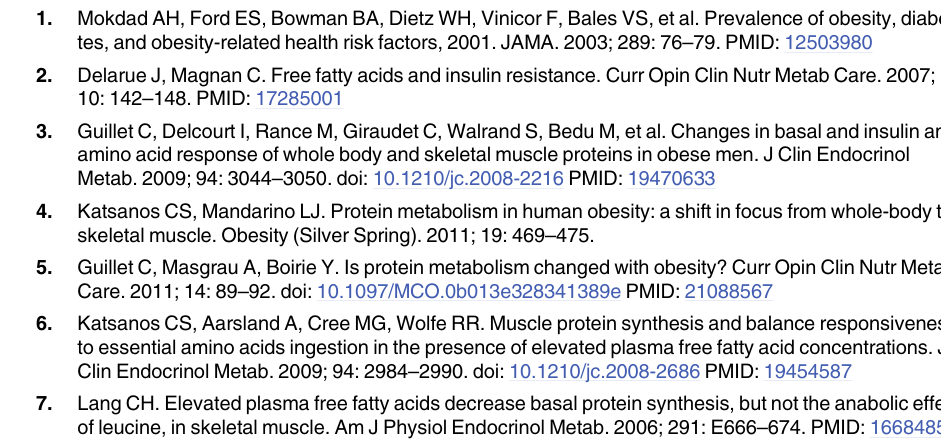
S7 Fig. Control experiments. (A) LC-MS/MS verification of β -F1-ATPase protein in the ~50 kDa band precipitated by the β -F1-ATPase antibody. (B) Bioanalyzer results of RNA ladder (left) and total RNA extracted from exosomes (right) showing presence of small RNAs. (C) Amplification curve, melting curve, and DNA agarose gel for qRT-PCR analysis of hsa-miR- 127-5p expression in serum exosomes. (D) Total proteins extracted and Western blot analysis of desmin (~50 kDa), GAPDH (~37 kDa), and CD-9 (~27 kDa) from serum exosomes. (E) DNA agarose gel, amplification curve, and melting curve for qRT-PCR analysis of hsa-miR- 127-5p expression in exosomes extracted from myotube culture media. (TIFF) S8 Fig. Model of β -F1-ATPase Translation Regulation in Obesity. Genetic and epigenetic factors unmask transcription of miR-127-5p, which can then bind to the 3 ’ UTR of the ATP5B mRNA and block ribosomal translation machinery from accessing the transcript. (TIF) S9 Fig. Western blots. Original, uncropped, and unadjusted western blots for the data pre- sented in the Figures in the Results Section.